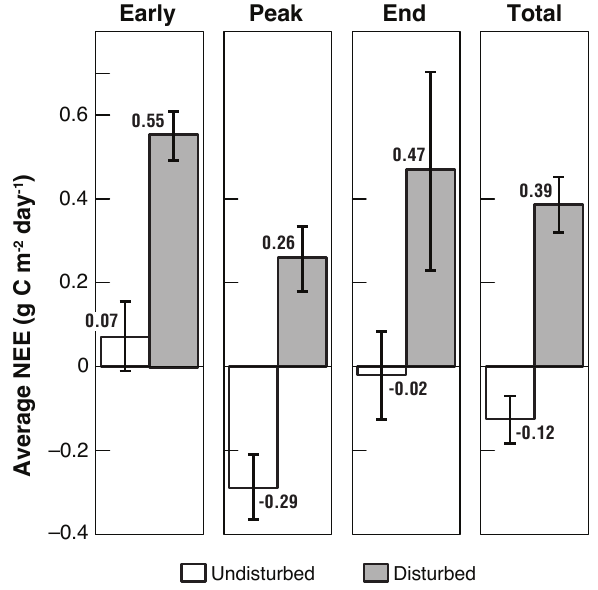
Figure 5. Ensemble diurnal course of CO 2 fluxes from the retro- gressive thaw slump (disturbed) and undisturbed tundra separated into the three sampling periods: top (early season), middle (peak season), and bottom (end season). Boxes show the 25th and 75th percentiles; black circles are outliers; horizontal lines are medians.